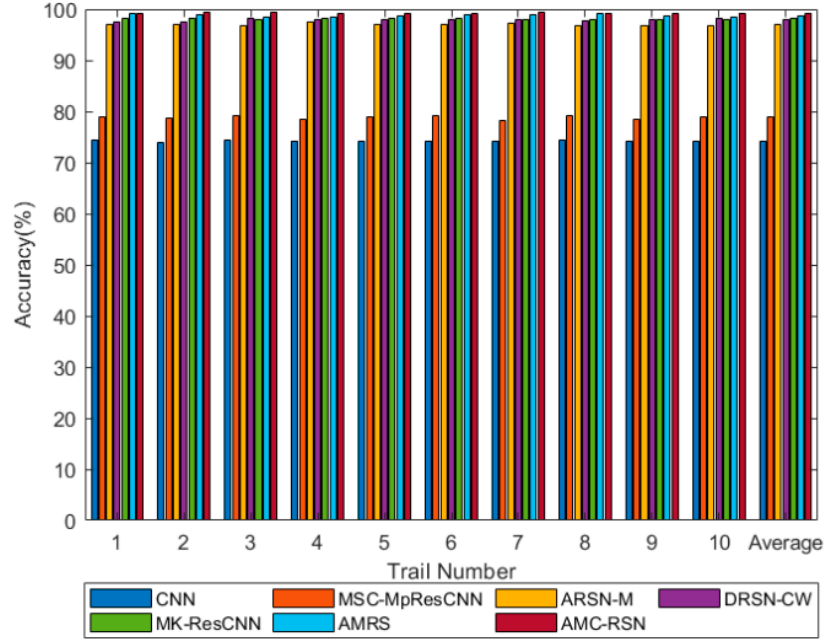
Figure 6. Diagnostic results of different models for the bearing datasets.